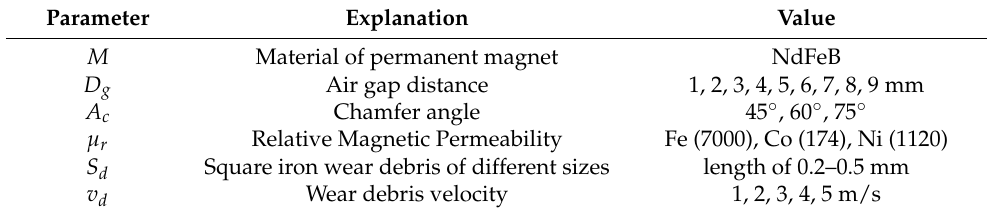
Table 1. Parameters discussed in the simulation.